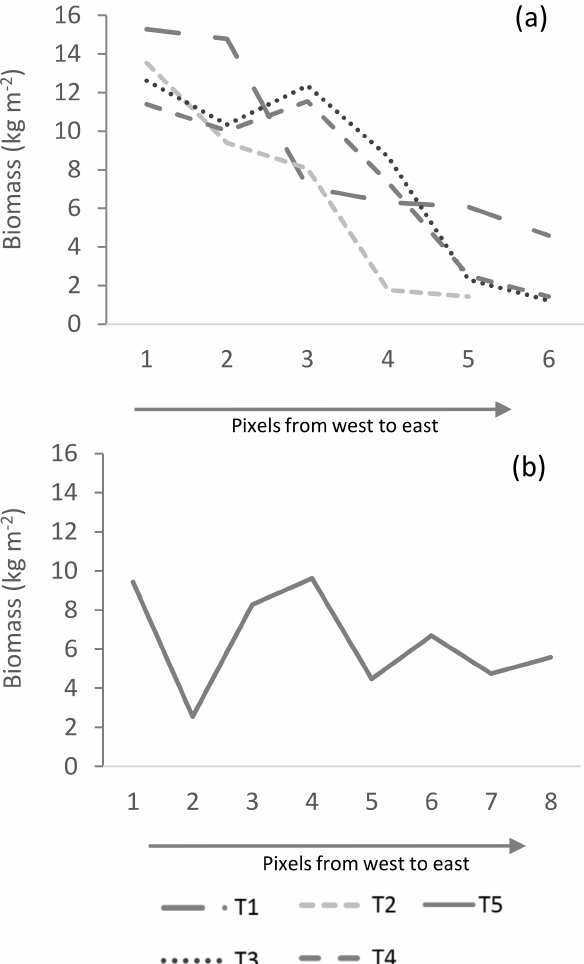
Figure 3. Average variations in aboveground biomass (AGB) in pix- els from west to east in the Amazon–Cerrado transition for transects (a) T1, T2, T3 and T4, and (b)